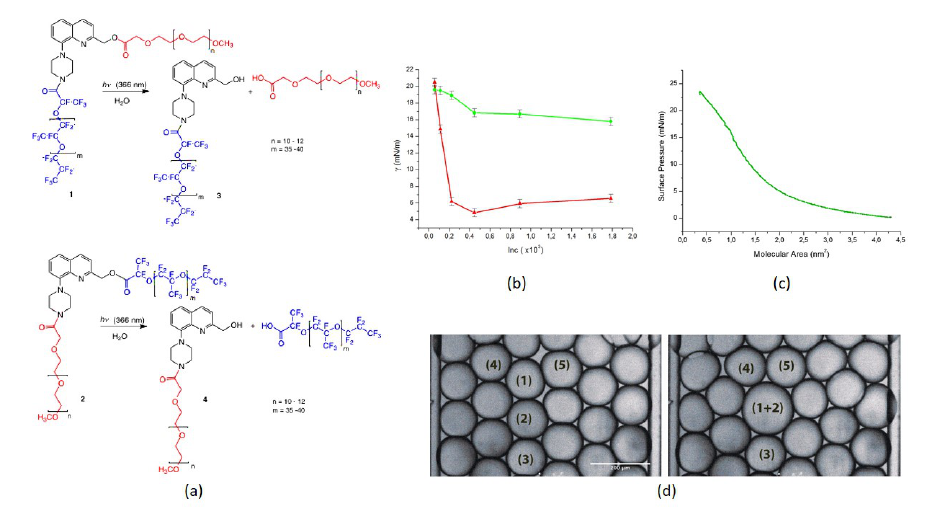
Figure 7. Surfactants 1 and 2: ( a ) Chemical composition; ( b ) Interfacial tension versus concentration, red curve for Surfactant 1 and green curve for Surfactant 2; ( c ) Surface pressure versus molecular area; ( d ) Light-induced merging of droplets 1 and 2. Reproduced with permission from